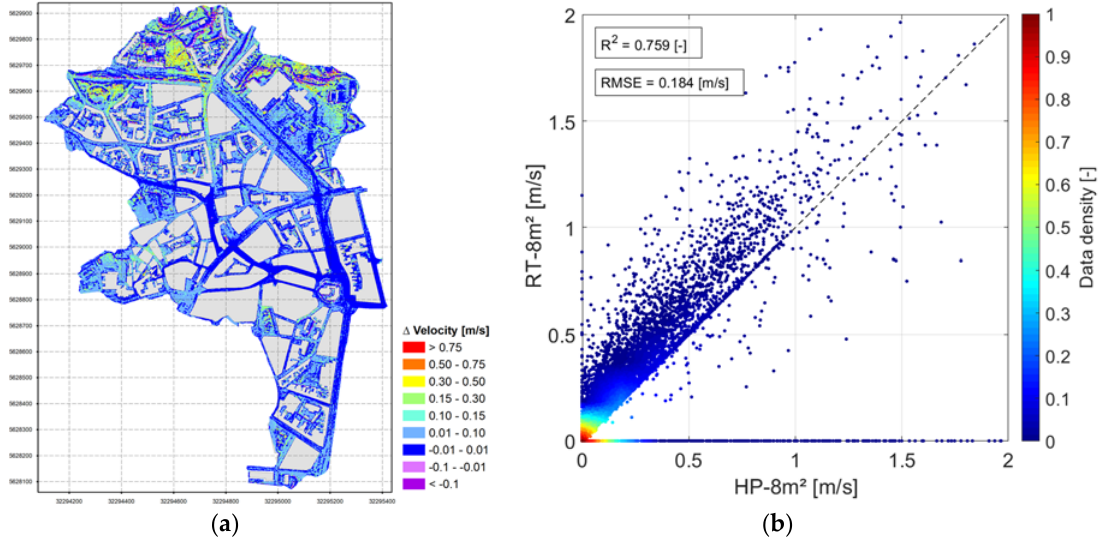
Figure 9. ( a ) Maximum velocity difference between HP ‐ 8 m 2 and RT ‐ 8 m 2 shown on a 2D ‐ difference map, and ( b ) on a scatterplot